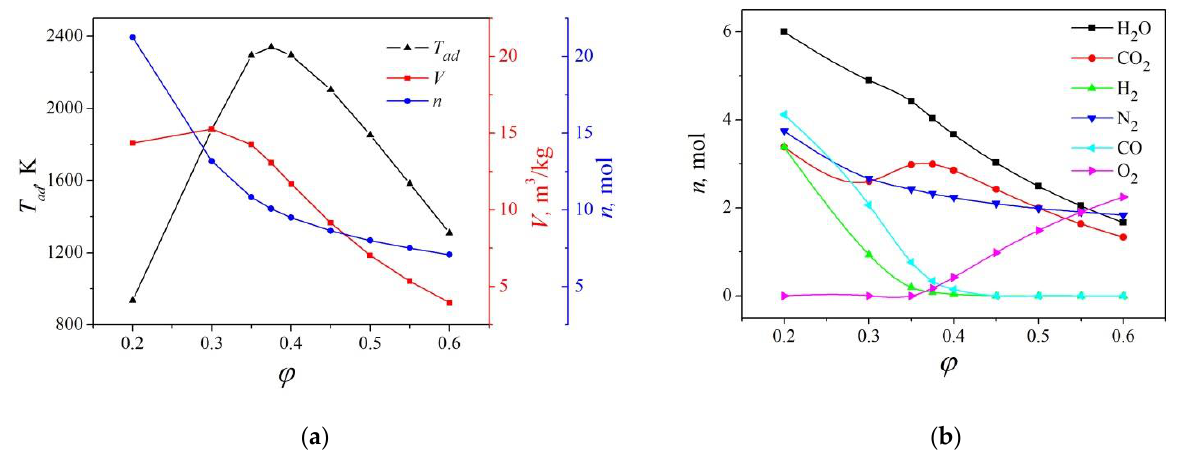
Figure 1. Dependence of ( a ) adiabatic temperature ( T ad ), volume ( V ), and number of moles ( n ) of volatile reaction products; ( b ) amount of the main volatile reaction products in the precursor composition ϕ Y(NO 3 ) 3 –(1- ϕ )NH 2 CH 2